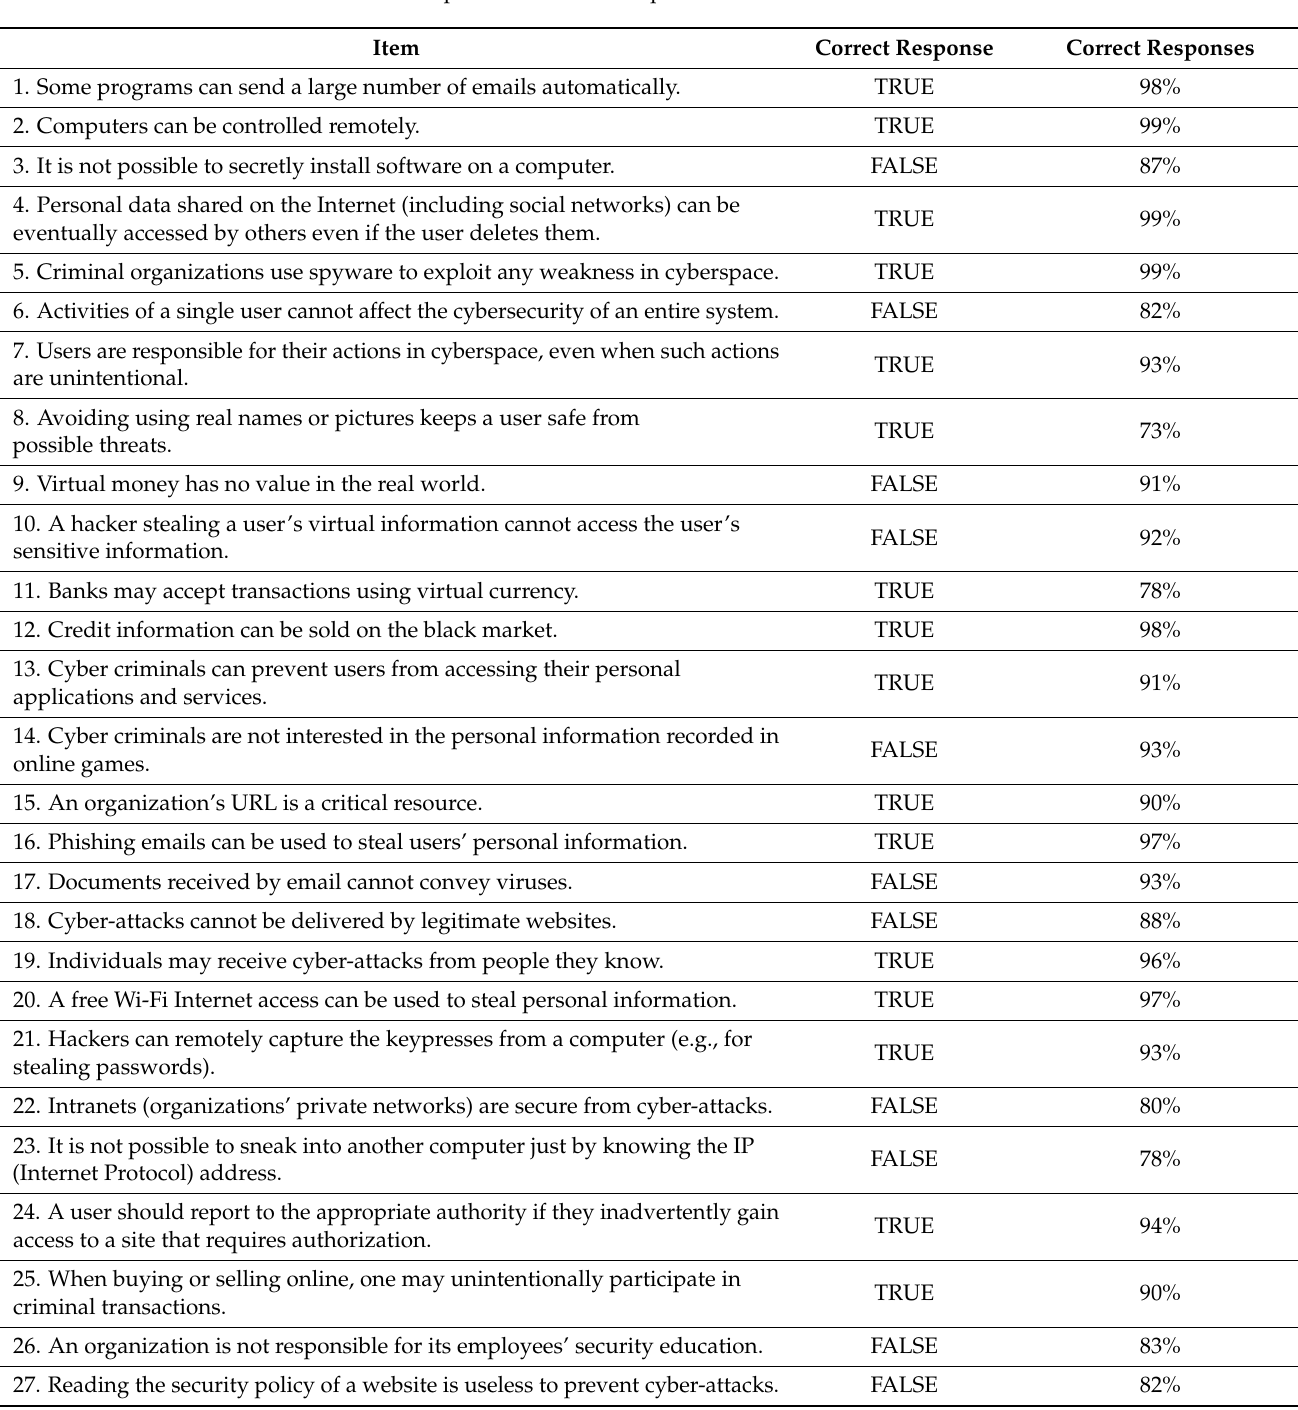
Table 1. Proportion of correct responses for each CAIN